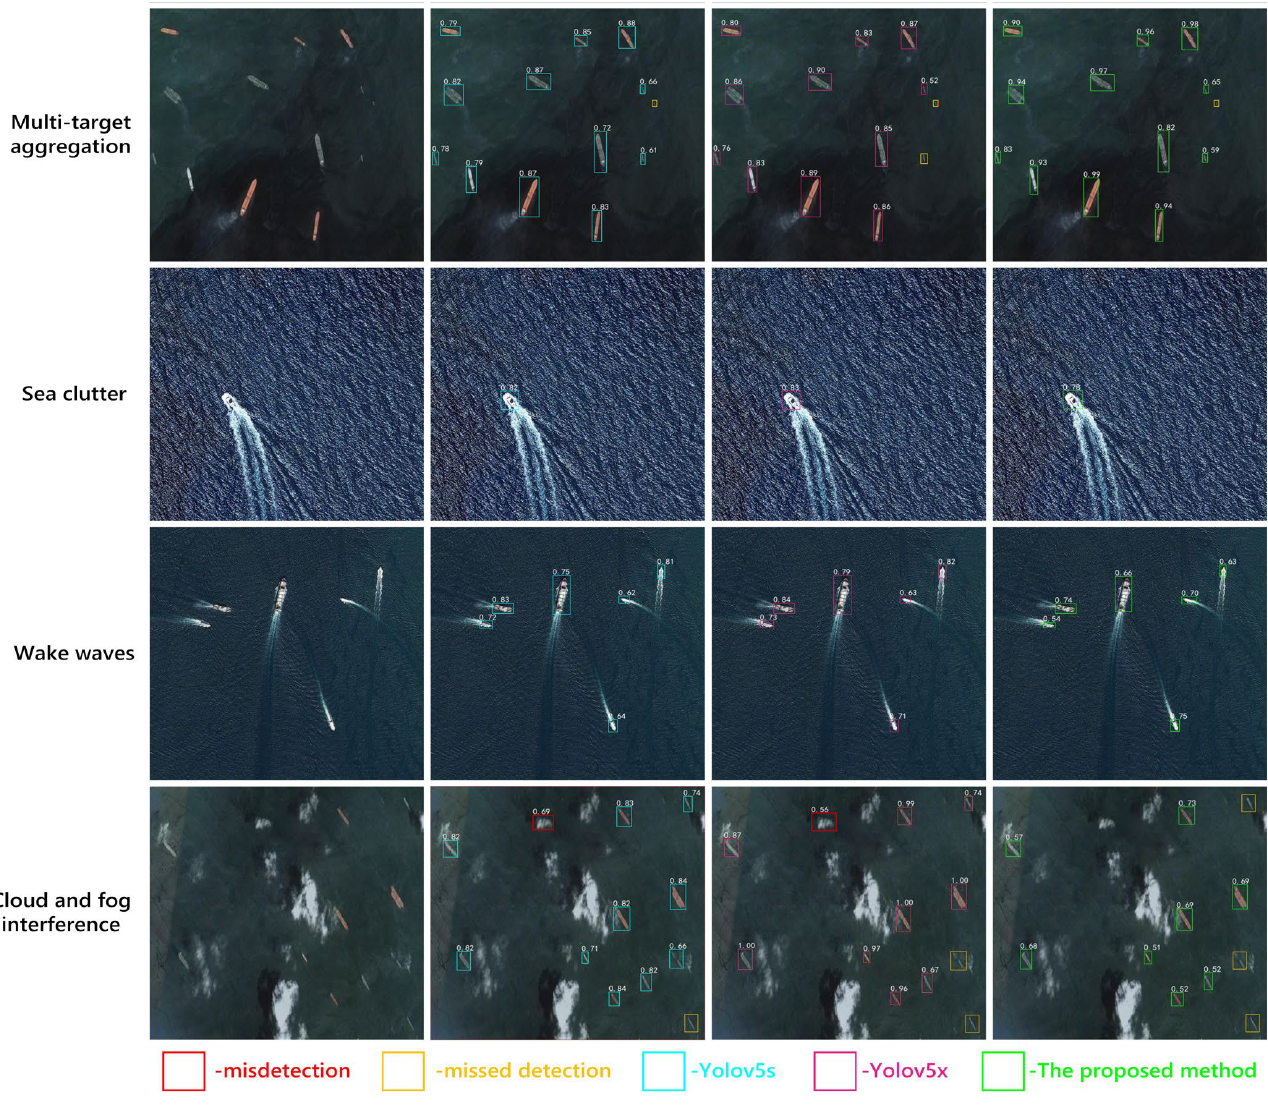
Figure 17. Visualization results of the best three methods. Note that the above six cases are shown in the figure, including small-sized ships, medium-sized ships, multi-target aggregation, sea clutter, wake waves, and cloud interference. In marine ship detection, the actual scene often contains a combination of the above six situations under different illumination levels. Part of the images in the figure is also the result of various combinations. For example, the fourth row includes both wake waves and sea clutter. Moreover, the last row shows the results of small-sized ships and medium-sized ships under cloud and fog